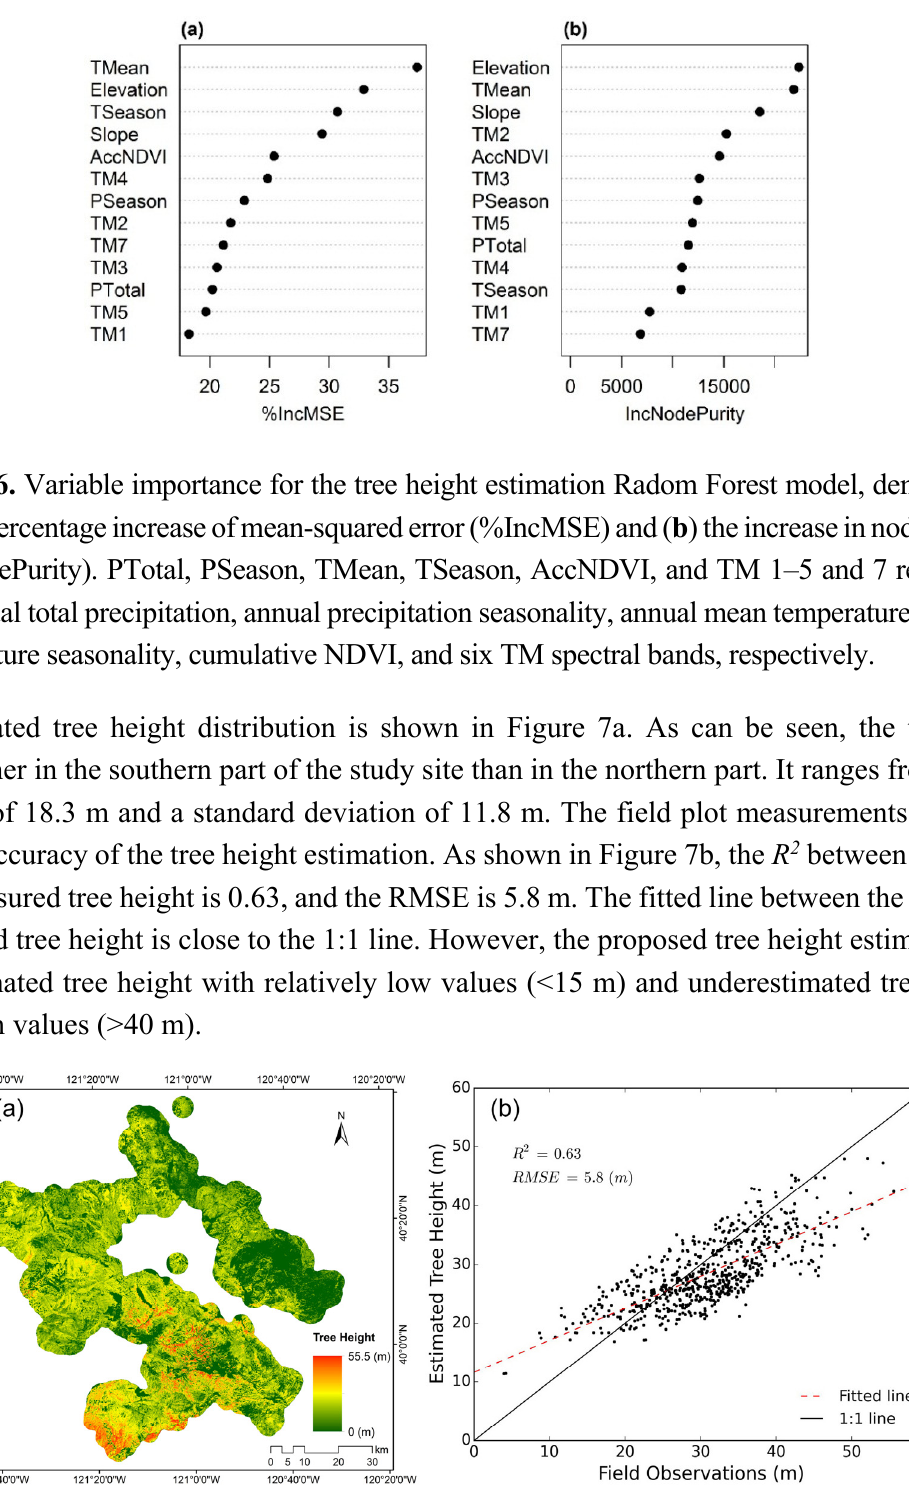
Figure 7. ( a ) Estimated tree height distribution in the study area; ( b ) Scatter plot between the estimated tree height and field